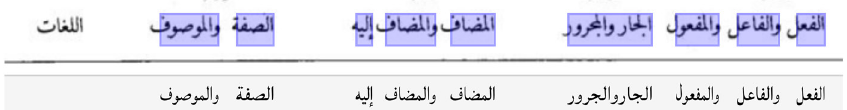
Figure 31: Line segmenter missed final word in the